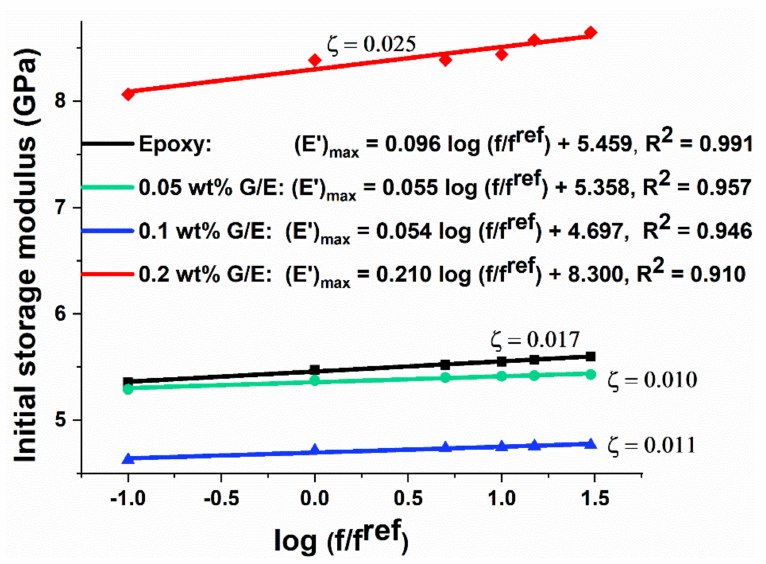
Figure 9. Effect of frequency on initial storage modulus of pristine epoxy and GO samples.